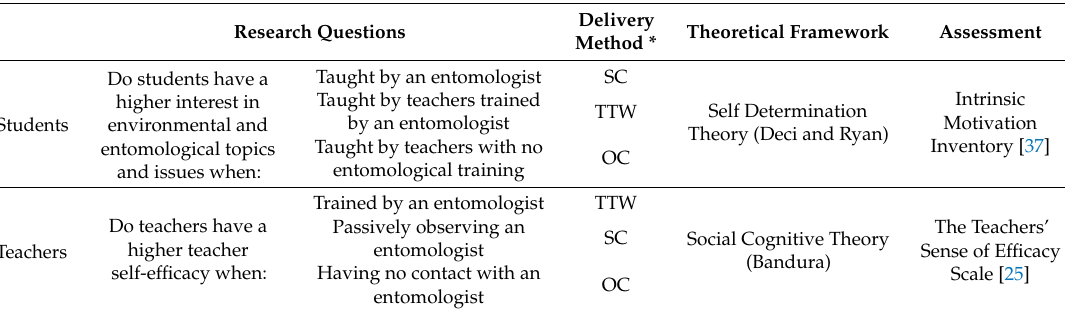
Table 4. Overview of the study for both students and